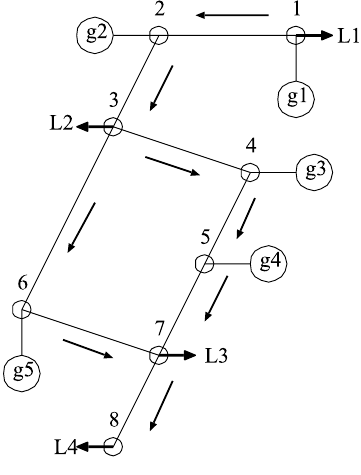
Figure 21. Power system model.